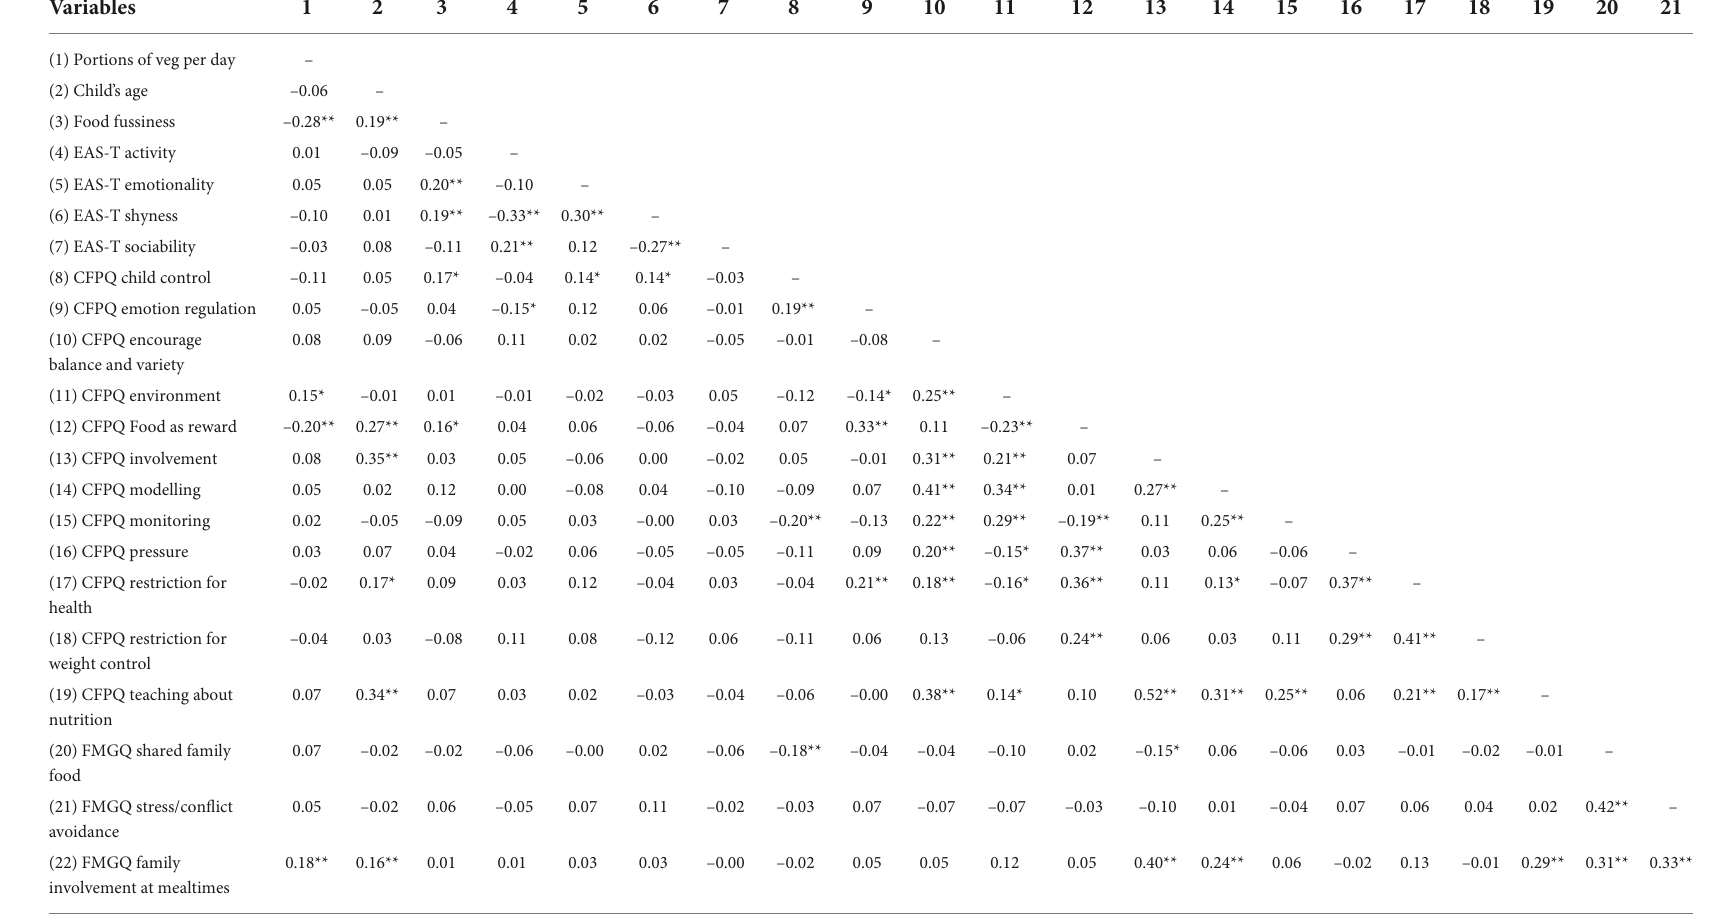
TABLE 5 Correlations between vegetable consumption and parent and child measures, all children included ( N = 408) ††† .